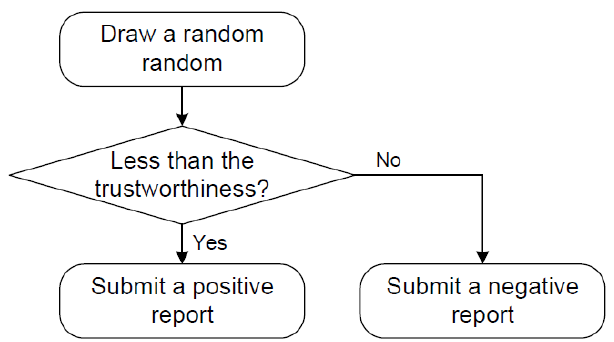
Figure 9. How to simulate traffic